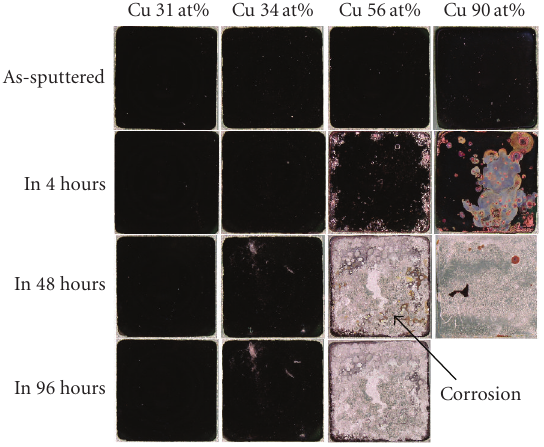
Figure 6: Salt spray test result of as-sputtered Zr-Cu binary films in various spraying